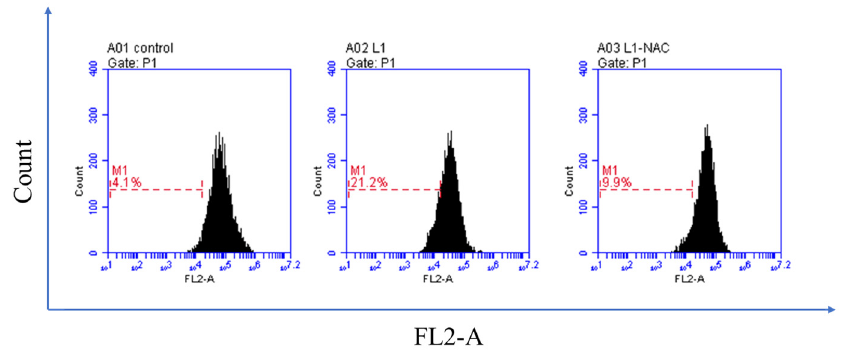
Figure 4. ROS generation assay of L 1 in HepG2 cells. Cells not treated with L 1 were used as the control for 48 h, while other cells were treated with L 1 (25 µ g/mL) and added NAC after treatment with L 1 (25 µ g/mL) for 48 h,